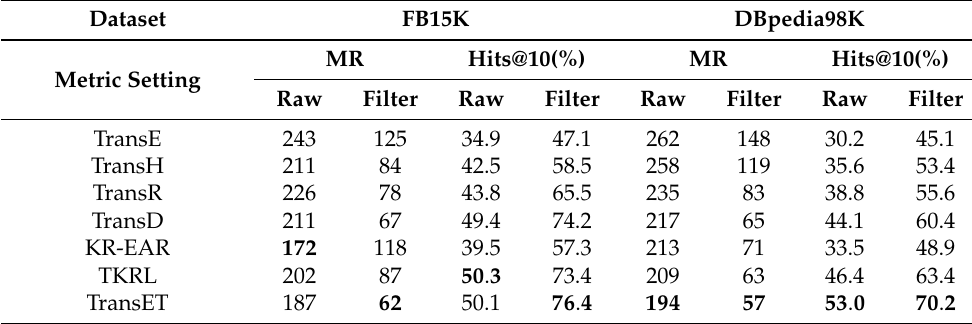
Table 3. Experimental results of link prediction.